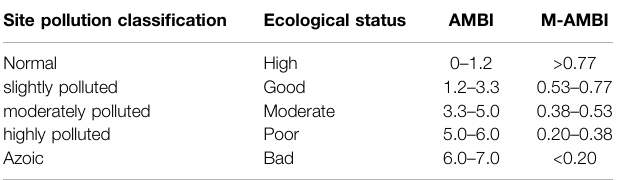
TABLE 1 | Threshold levels and ecological status (ES) for the AZTI ’ s Marine Biotic Index (AMBI) and Multivariate AZTI ’ s Marine Biotic Index